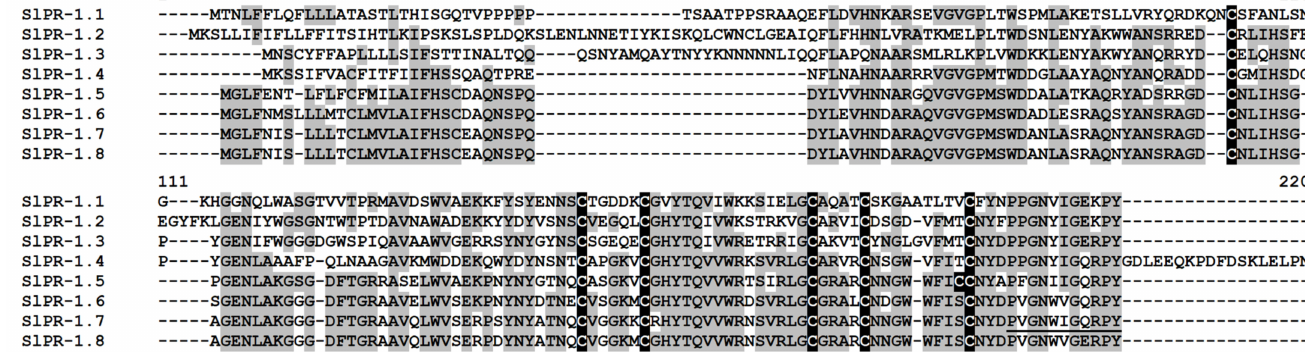
Figure 16. Multiple sequence alignment of S. lycopersicum PR-1 precursors. Cysteine residues are shaded black, and identical amino acids are shaded gray. The mature CAPE1 peptide sequence is